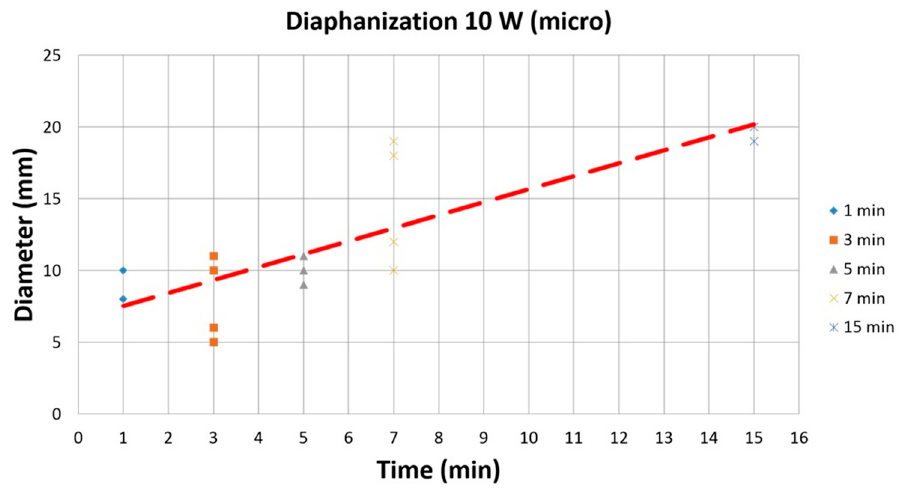
Figure 7. Histologic “parenchymal hypochromia” diameters and ablation times at 10 W. Parenchymal hypochromia diameter ( Y -axis) increases linearly with ablation time ( X